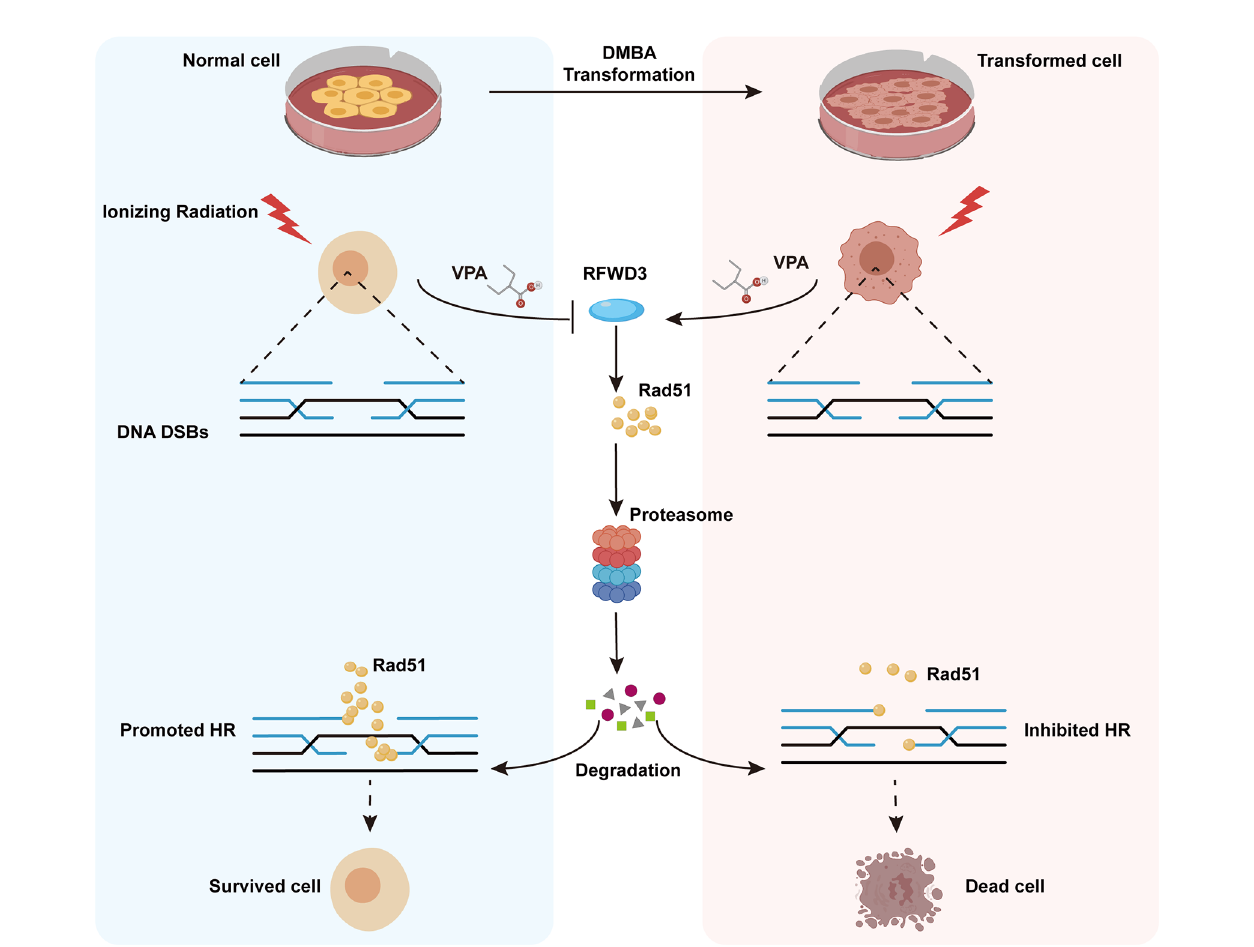
FIGURE 7 | Working model illustrates the radiosensitizing and radioprotection effect of VPA. VPA sensitizes malignantly transformed cells while protects normal cells to IR treatment. VPA enhances the DSBs level in malignant cells and alleviates the DSBs level in normal cells through regulating HR function. RFWD3 is targeted by VPA to manipulate the ubiquitination of Rad51. VPA inhibites RFWD3 to decrease the ubiquitination of Rad51 in normal cells in response to IR-induced DSBs, protecting Rad51 from degradation, while the ubiquitination is enhanced in malignant